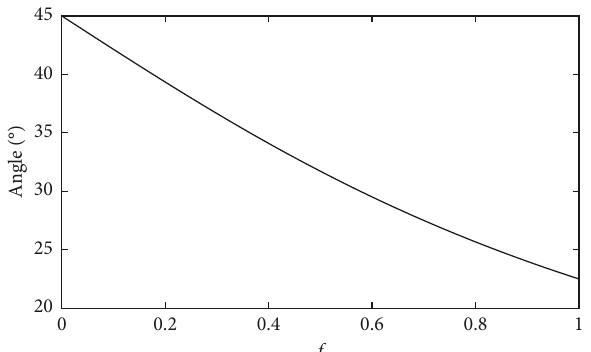
Figure 5: Relationship between friction coefficient and initial angle of crack